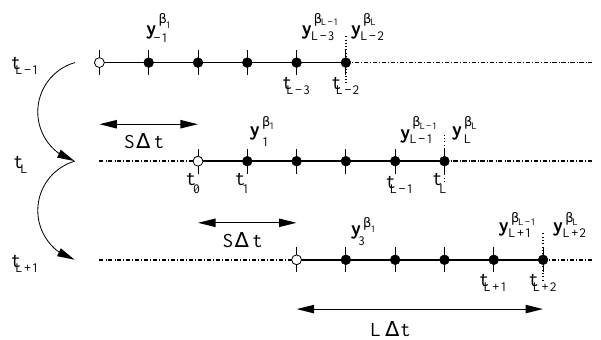
Fig. 2. Chaining of the MDA IEnKS cycles. The schematic illus- trates the case L = 5, and S = 2. The method performs a smooth- ing update throughout the window potentially using all observations within the window (marked by black dots), except for the first ob- servation vector assumed to be already entirely assimilated. Note that the time index for the dates and the observations are absolute for this schematic, not relative.